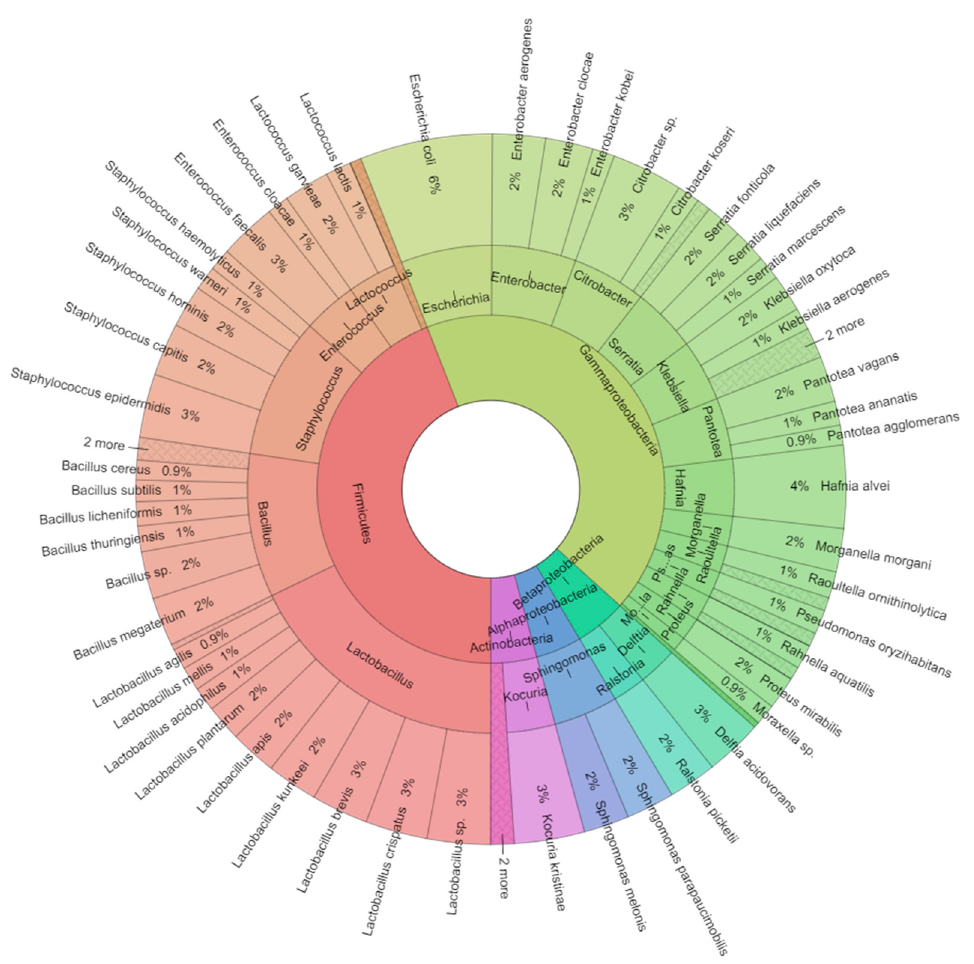
Figure 1. Krona RSF display of total bacteriota isolated from bee digestive tracts. Presented are the frequencies of detected species, genera and classes, from the outer ring inwards.